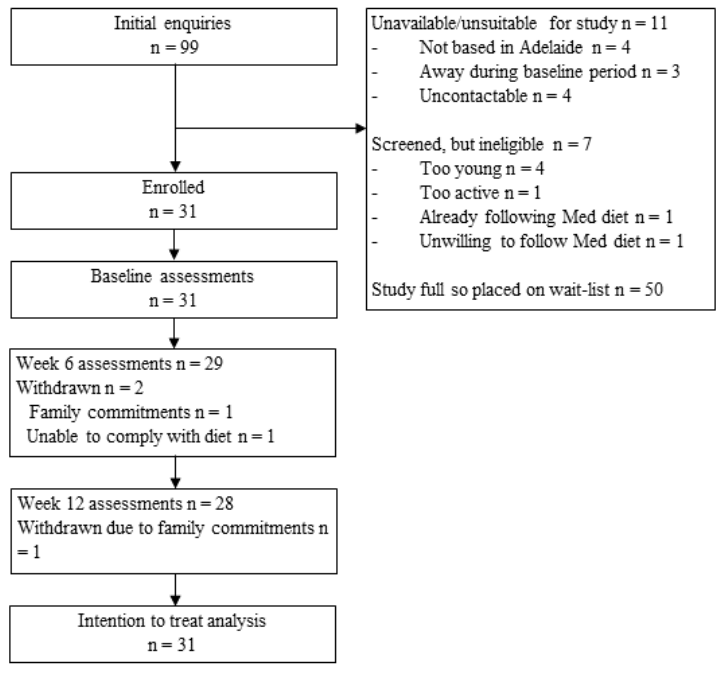
Figure 2. Participant flow through the